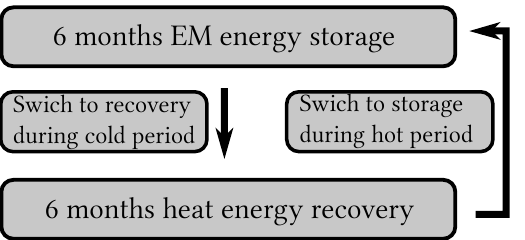
Figure 2. Schematic representation of the proposed energy storage through EM